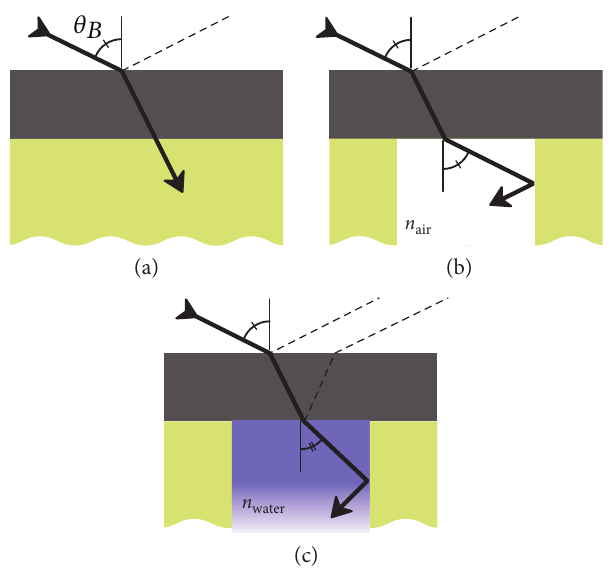
Figure 7: Ray diagram illustration of the Brewster ’ s angle re fl ection geometry for (a) a continuous rubber interface, (b) an air- fi lled void, and (c) a water- fi lled void. The dashed lines indicate signi fi cant re fl ected the topmost dashed rays in Figures 7(a), 7(b), and 7(c).